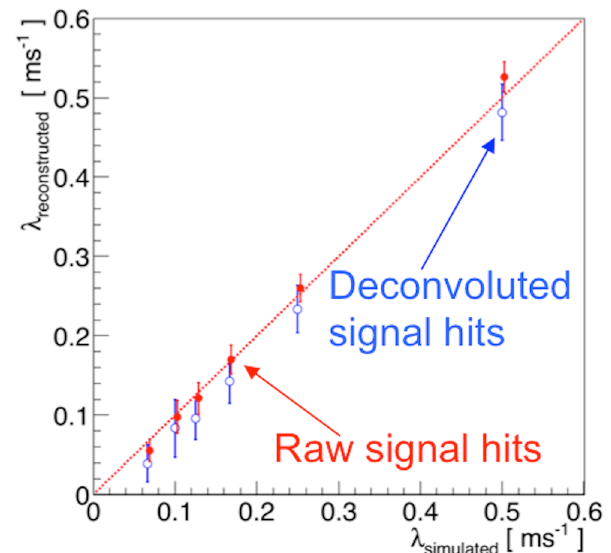
Figure 7. Preliminary results from the updated method for the measurement of the electron lifetime τ = 1/ λ in liquid argon, to be used during the new data taking at Fermilab. Two different methods related to the identification and reconstruction of the physical signals on the TPC wires (“hits”)